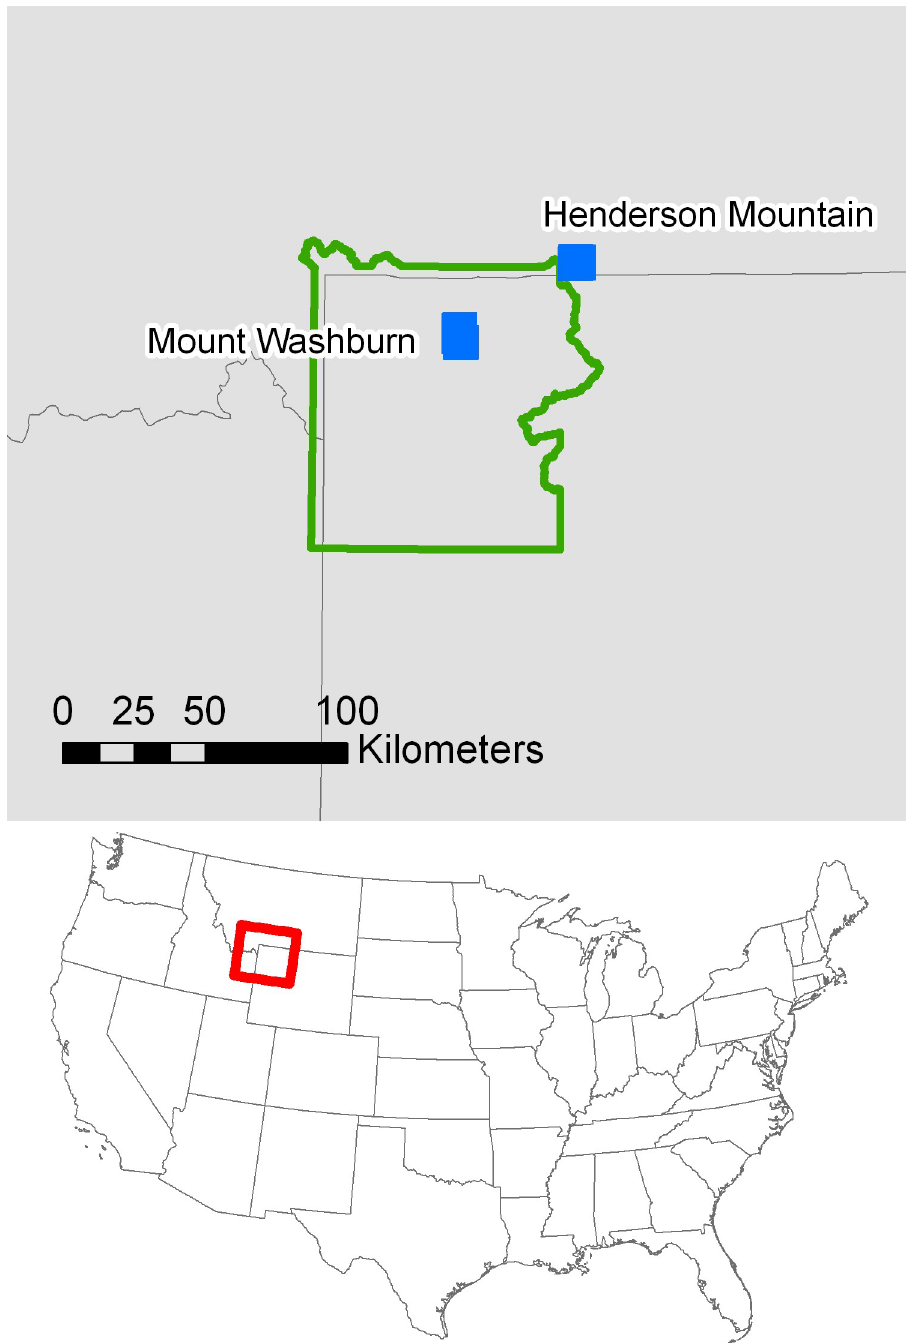
Fig 1. Map of sample collection locations. Top: Sample collection locations for Pinus albicaulis Engelm. (Pinaceae). Henderson Mountain, Custer Gallatin National Forest, MT and Mt. Washburn, Yellowstone National Park, WY. Bottom: Geographic location of Yellowstone National Park, Central Rocky